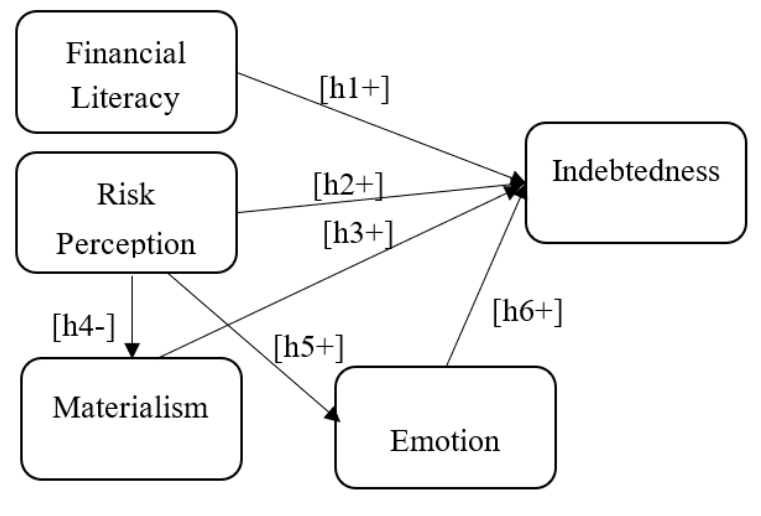
Figure 1. Theoretical model.